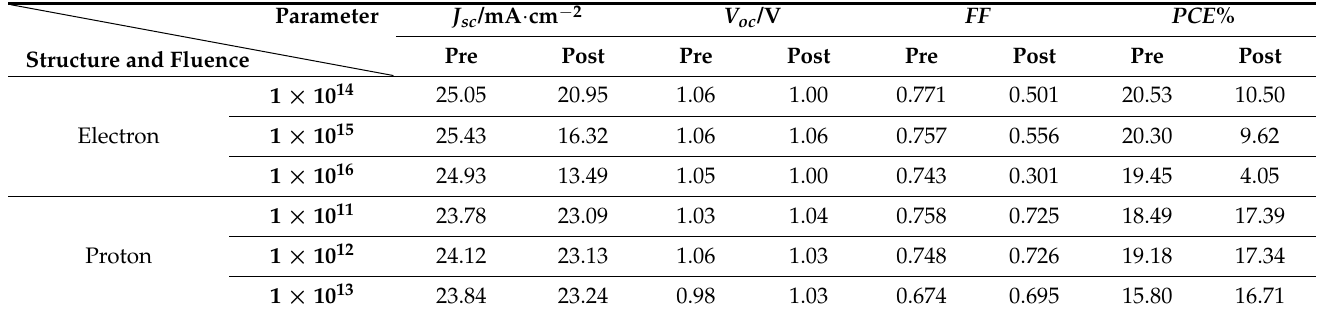
Table 1. Results of electron and proton irradiation